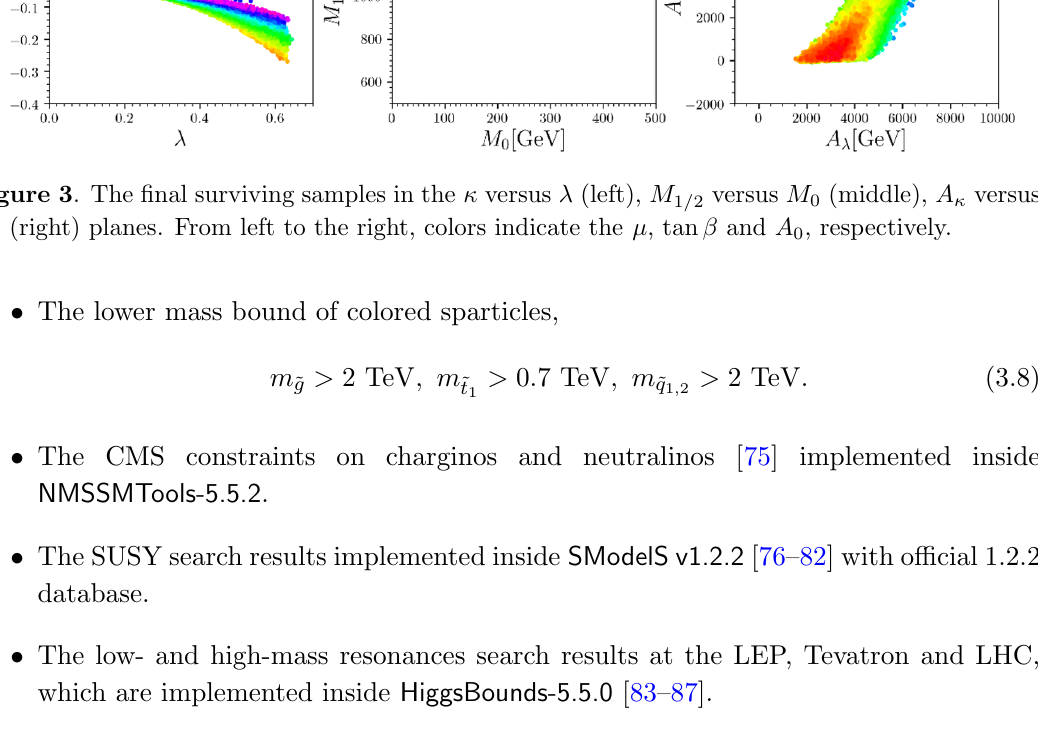
versus M 0 (middle), A (cid:20) versus 1 = 2